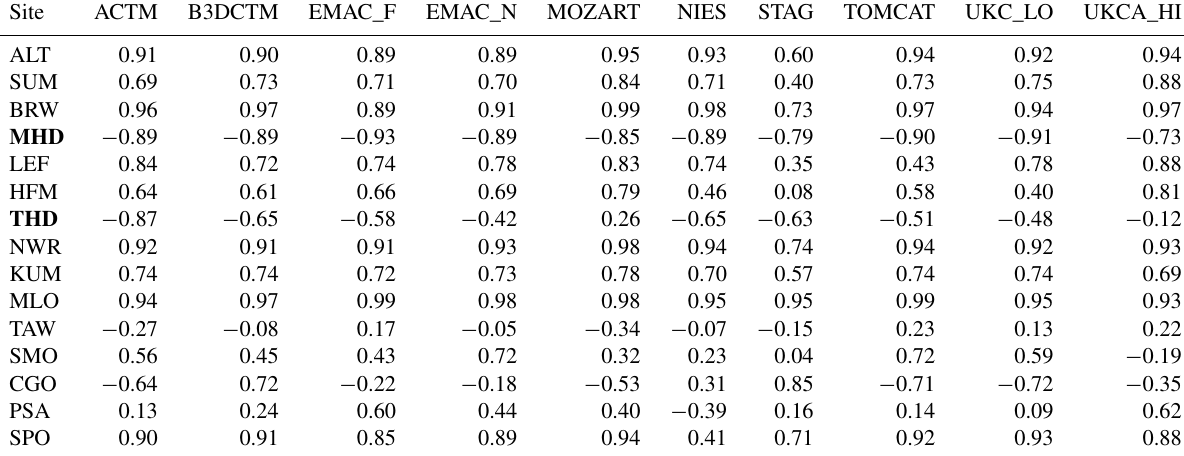
Table 4. Correlation coefficient ( r ) between the observed and simulated climatological monthly mean surface CHBr 3 volume mixing ratio (at ground-based monitoring sites, Table 3). Model output based on CHBr 3 _L tracer (i.e. using aseasonal emissions inventory of Liang et al., 2010). Stations in bold denote where virtually all models fail to reproduce phase of the observed CHBr 3 seasonal